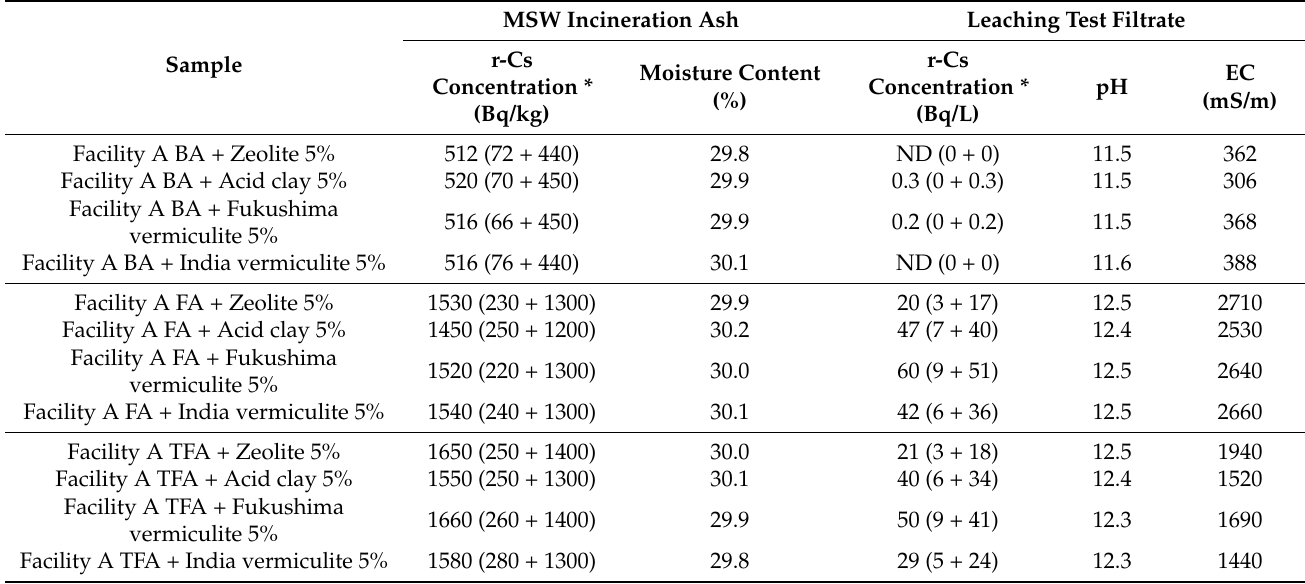
Table 3. Concentration and leaching of radioactive cesium (r-Cs) upon direct addition and mixing of clay minerals at 5 wt.%.